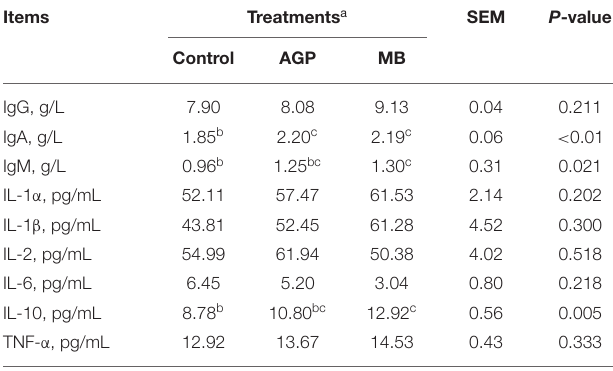
TABLE 4 | Effects of dietary Macleaya cordata extract and Benzoic acid supplementation on immune property of weaned piglets. Items